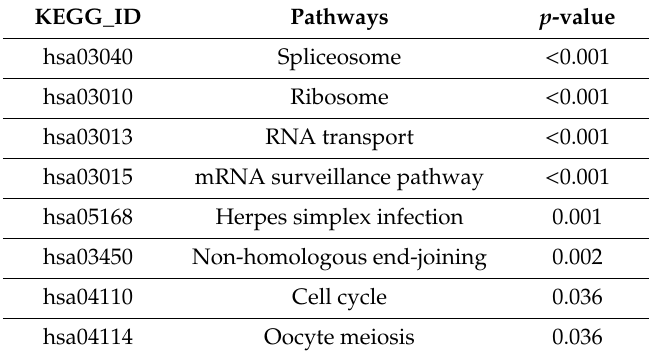
Table 1. Significant pathways where SDC1 interacts with nuclear proteins.